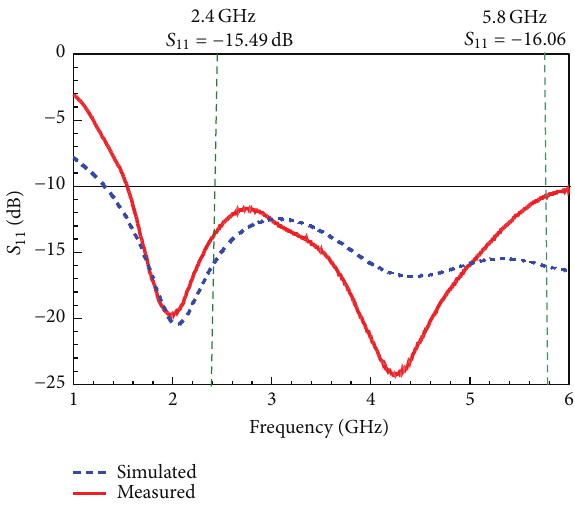
Figure 4: Simulated and measured return loss of the proposed antenna.